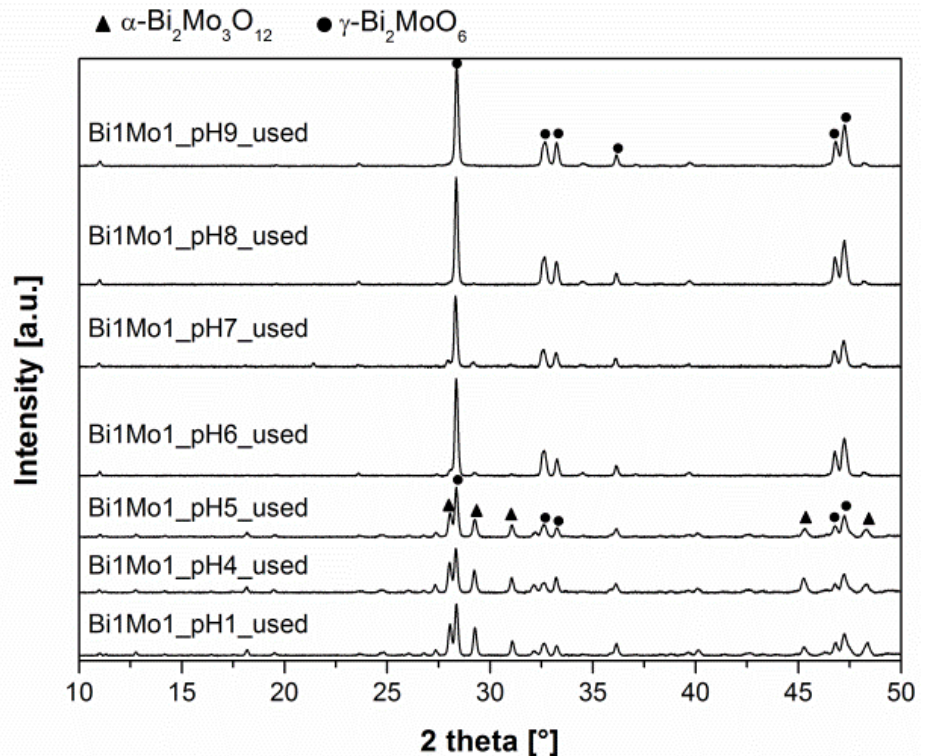
Figure 6. XRD patterns of the samples synthesized with Bi/Mo = 1/1 at different pH values after application in catalytic oxidation of propylene at temperatures up to 520 °C. The following symbols are used for marking the reflections of the different phases: α-Bi 2 Mo 3 O 12 (▲) and γ-Bi 2 MoO 6